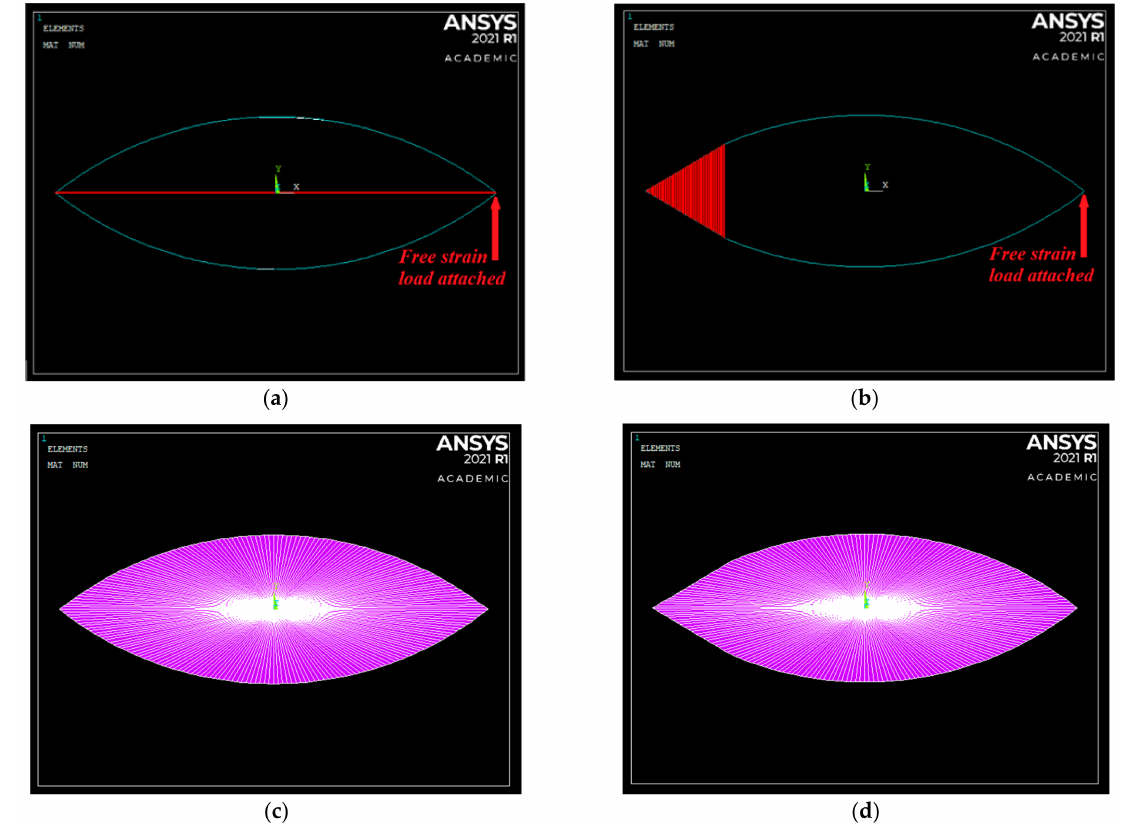
Figure 20. (Above) ( a ) Pouch geometry for the sliding mechanism with the structural element BEAM189 represented by the light blue elements, and the transducer element TRAN126 represented by the red elements. ( b ) Pouch geometry for the zipping mechanism with the structural element BEAM189 represented by the light blue elements, and the transducer element TRAN126 represented by the red elements. ( c ) The hydrostatic elements of sliding mechanism which is attached to the BEAM189 element; ( d ) the hydrostatic elements of the zipping mechanism with the straight structure where the TRANS126 elements would be attached.